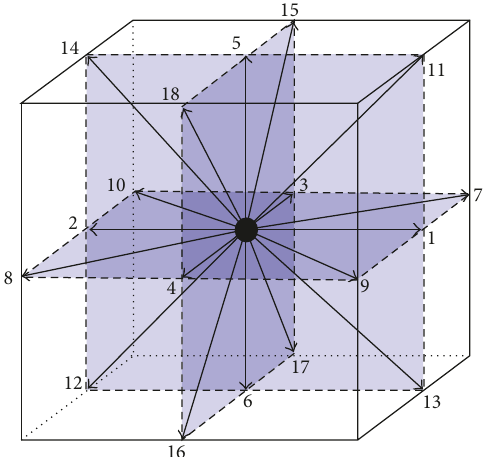
Figure 7: D3Q19 lattice with 18 discrete velocity directions for a particle at